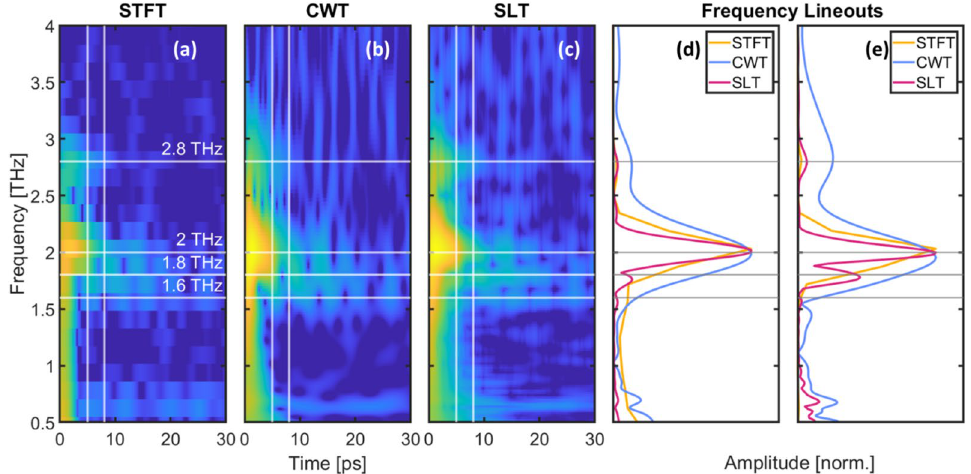
Figure 4. Demonstration of SLT performance using real data taken with 0.081 mJ/cm 2 pump fluence. ( a – c ) STFT, CWT, and SLT spectrograms, respectively. Lineouts were taken at 5 ps ( d ) and 8 ps ( e ) indicated by the vertical white lines in the spectrograms. Horizontal lines at 1.6, 1.8, 2, and 2.8 THz serve as a guide to the eye. The lineouts show that the SLT produces a narrower peak than either alternative, and provide better spectral resolution. The peak at 1.8 THz is not resolved by the CWT or STFT (blue, yellow, respectively), but is clearly present in the SLT lineout (red) at both 5 and 8